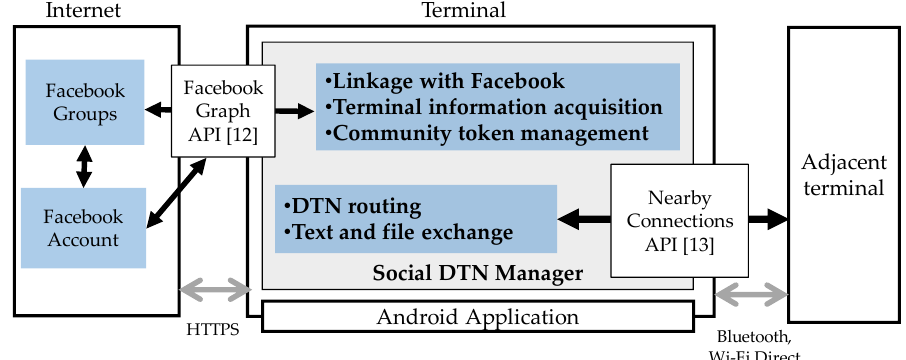
Figure 6. Configuration of the experimental system. Table 6. Main functions implemented.